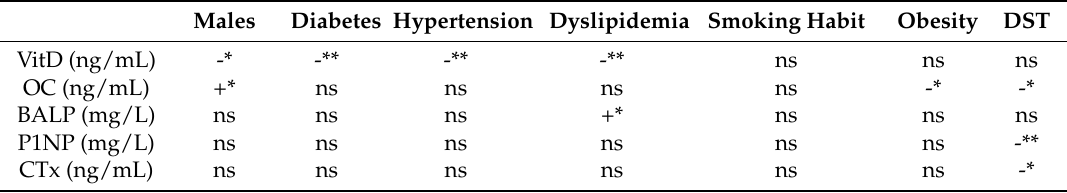
Table 4. Correlation between HBM and categorical variables.